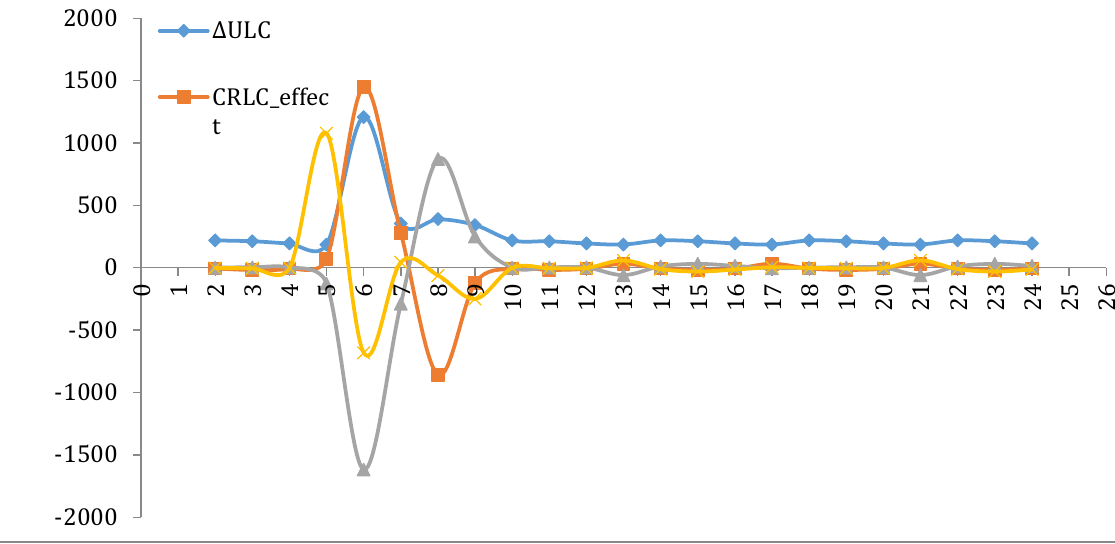
Table 1: Quarterly Logistics Costs Intensity change and it's driving factors (January 2010 - December 2015)